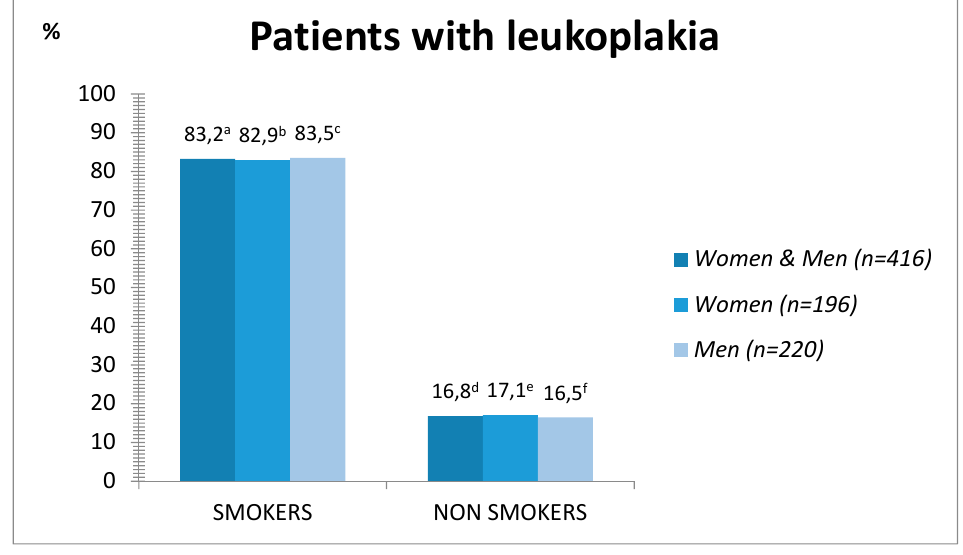
Figure 1. Percentage of patients diagnosed with leukoplakia smokers and non-smokers.